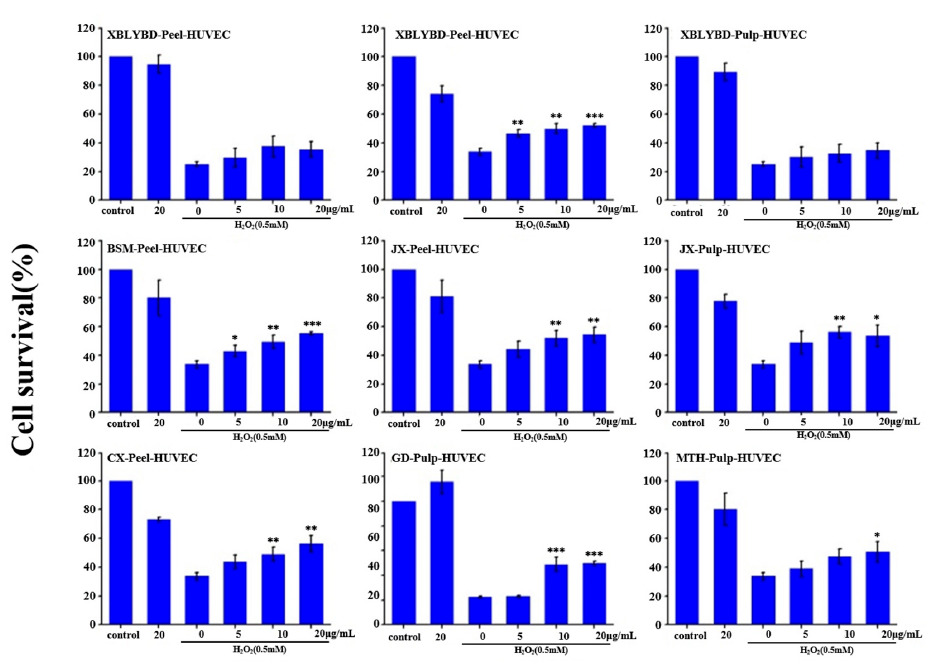
Figure 9. Protective e ff ect of apple extracts on human umbilical vein endothelial cells (HUVEC) under H 2 O 2 -induced stress. The names of apple cultivars were showed as abbreviations: CX for ‘Chunxiang’, BBSJN for ‘Babusijinuo’, XBLYBD for ‘Xiboliyabaidian’, BSM for ‘Basimei’, MTH for ‘Mantanghong’, JX for ‘Jingxiang’, GD for ‘Gold Delicious’. * indicated significant di ff erences at the 0.05 probability level, ** indicated significant di ff erences at the 0.01 probability level, and *** indicated significant di ff erences at the 0.001 probability level compared to the H 2 O 2 induced group without treating with apple extract using t test.